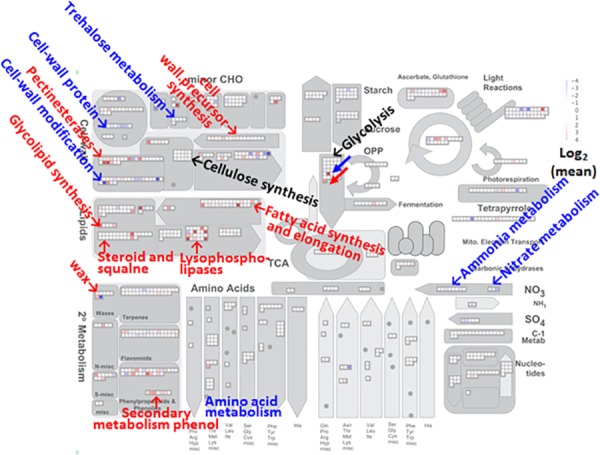
MapMan visualization of the differences in metabolism-related gene expression between FEC cultivated on CIM–Ρ NPK media and FEC cultured on CIM media.Each square represents a metabolism-related gene and displays a qualitative color code: red colors represent upregulated genes and blue colors represent downregulated genes in FEC cultured on CIM–Ρ NPK media, relative to FEC cultured on CIM media. The genes were selected from a microarray data set of comparative gene expression using the BH method (FDR <0.05) and when the gene exhibited two-fold differences (up or down) in expression as shown in S4 and S5 Tables. The means of expression data represent the average of four biological replicates. The scale of color shades represents the log2 values of the fold change of each of the metabolic genes. Red and blue arrows in the glycolysis metabolism section indicate PHOSPHOENOLPYRUVATE CARBOXYLASE KINASE 1 and PHOSPHOENOLPYRUVATE CARBOXYLASE KINASE 2, respectively. The blue and red words indicate GO categories that are upregulated (red) or downregulated (blue) as classified by MapMan. A black word indicates that there is no difference in this GO category.